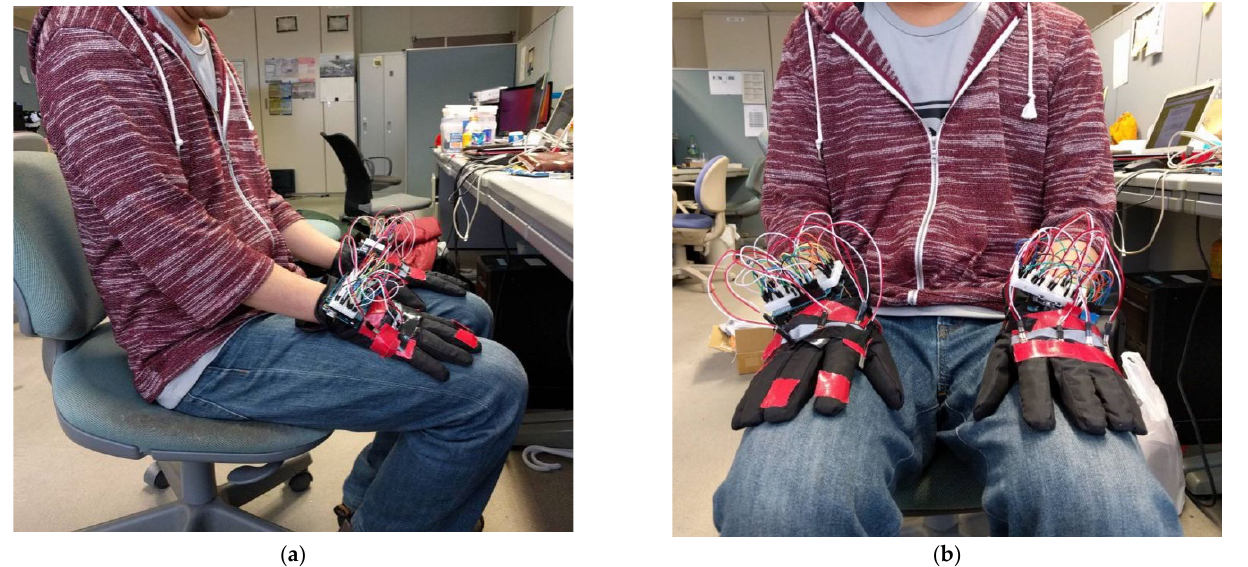
Figure 9. The basic pose and hand position during the usage of the system: ( a ) side view; ( b ) front view.